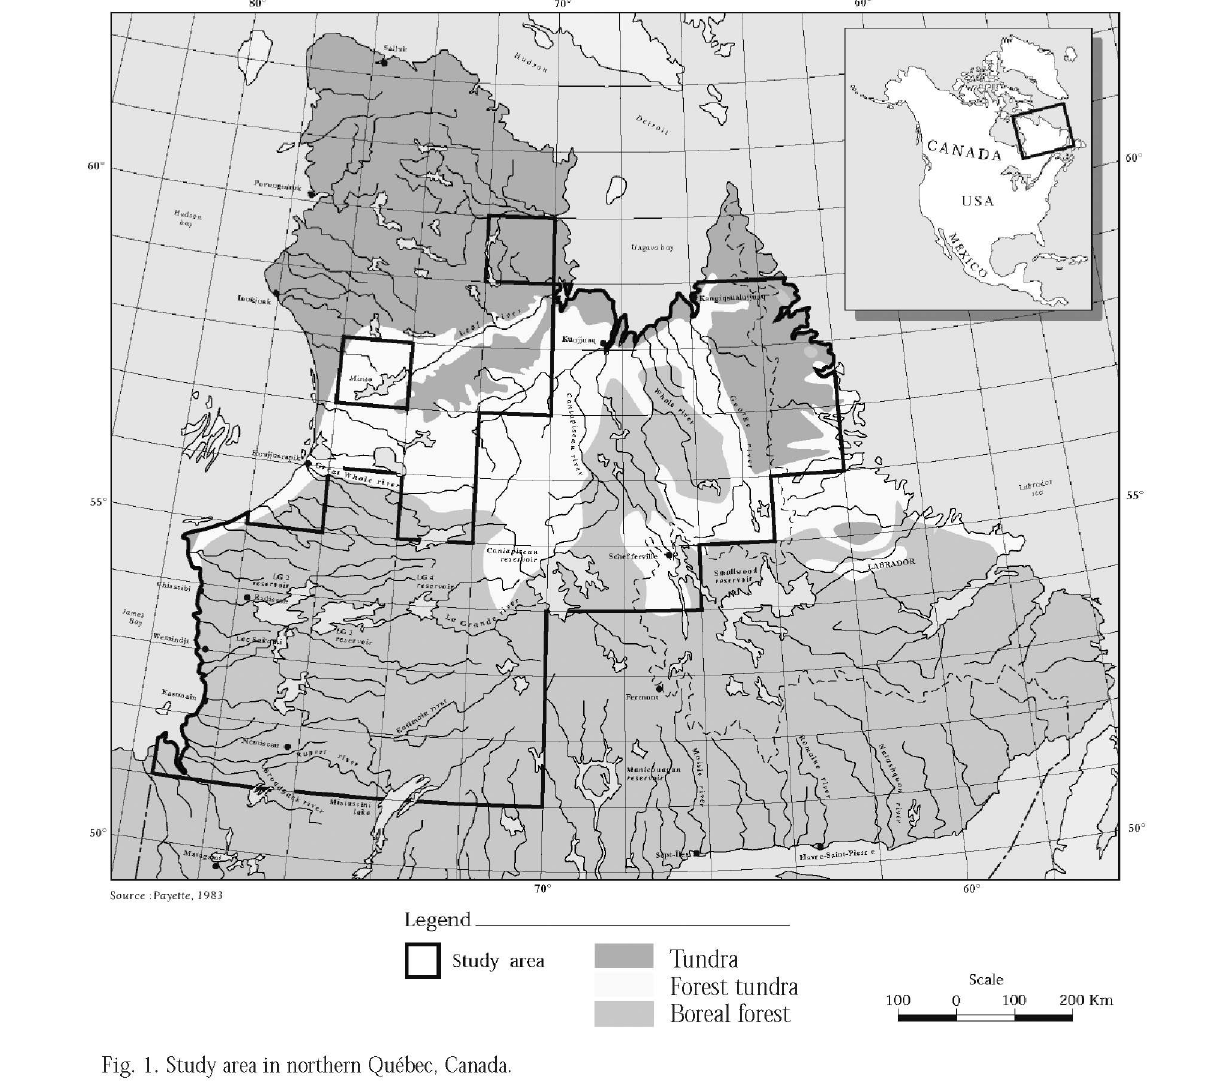
Fig. 1. Study area in northern Québec,